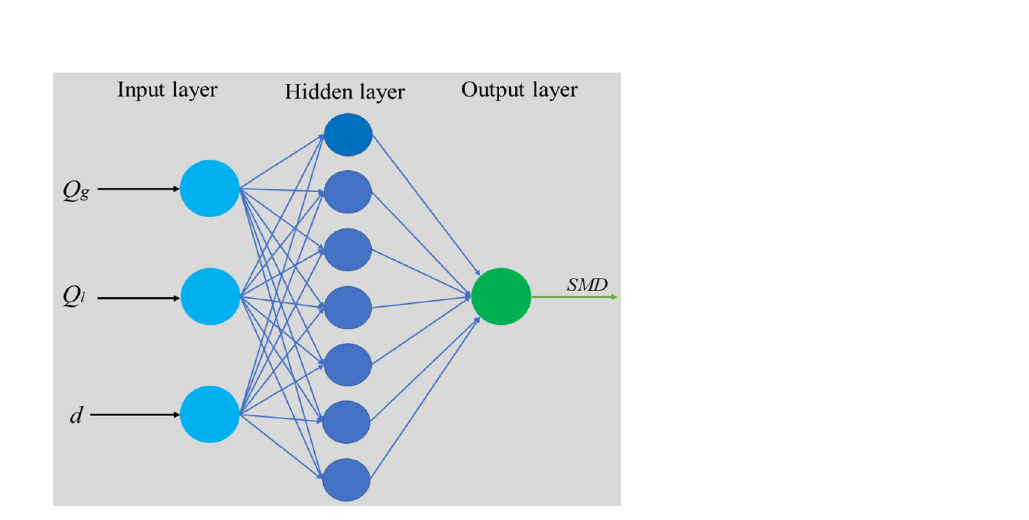
Figure 7. Schematic diagram of BP neural